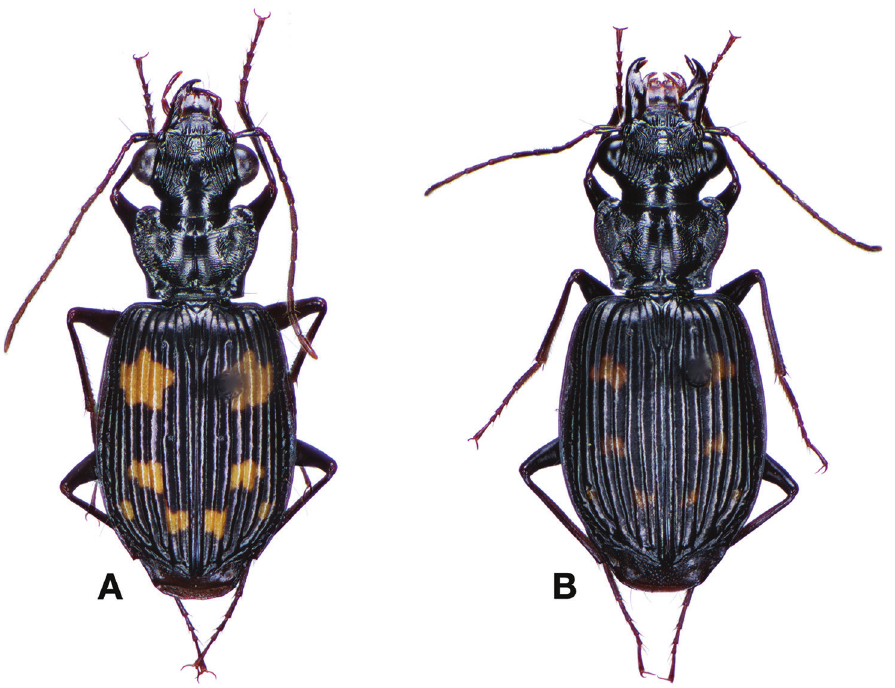
Figure 104. Dorsal habitus and intrapopulation variation of color pattern of Pericalus formosanus Du- puis. A larger elytral macula (common) (OBL 11.02 mm). B smaller elytral macula (OBL 8.02